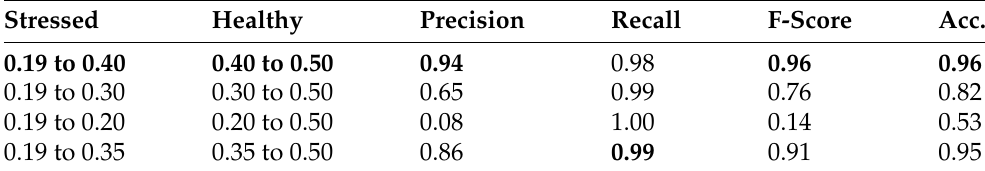
Table 9. Accuracy assessment using different threshold ranges at Level-3a classification for stressed and healthy regions. Note that each row represents the averaged metrics (Precision, Recall, F-score, and Accuracy) of four LGAs under Level-3a classification. The boldface represents the optimal threshold range and resulting best values.